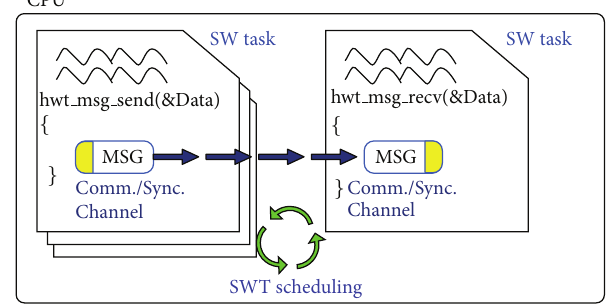
Figure 16: SW-SW channel-based